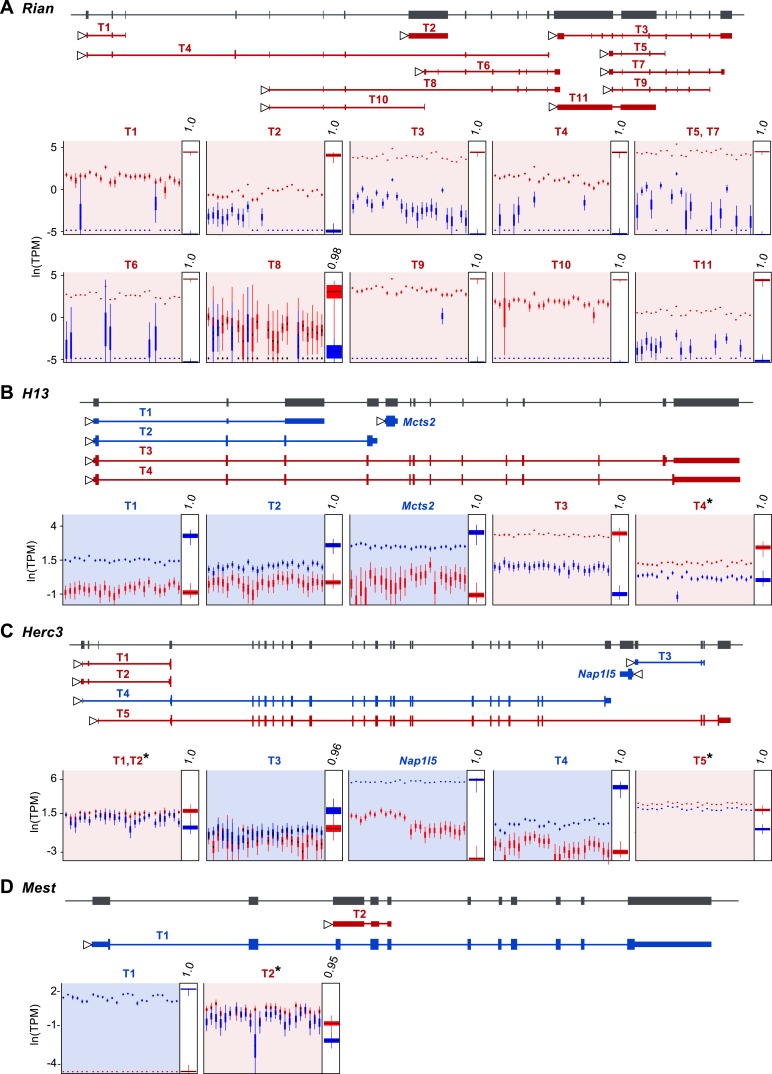
Assessment of imprinting at the transcript level.(A) Imprinting in all identified spliced variants of Rian in the P8 cerebellum. (B) Imprinting of Mcts2 and H13 transcripts in the P8 cerebellum. (C) Imprinting of Nap1l5 and Herc3 transcripts in the P60 cerebellum. (D) Imprinting in transcripts of Mest in the P60 cerebellum. In all figures, gene models are in dark gray and transcript models are colored according to the preferentially expressed parental allele (maternal in red and paternal in blue). Parental-specific expression across all replicates is shown below transcript models in natural log of TPM units (ln(TPM)), with the posterior distribution of the parental biases across replicates indicated in the right inset boxes with corresponding PPs on top. Asterisks indicate that the associated transcript is developmentally regulated.